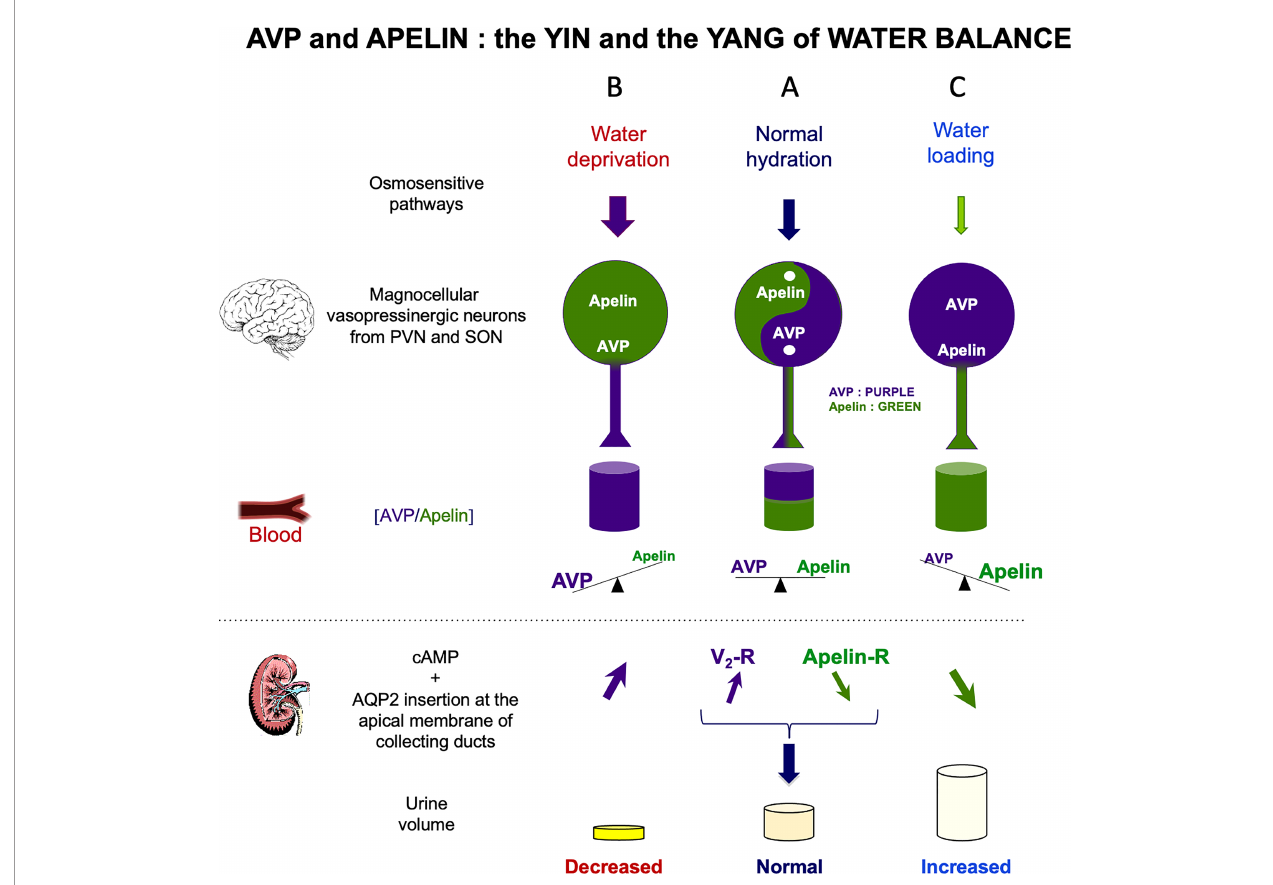
FIGURE 3 | Vasopressin (AVP) and apelin: the yin and yang of water balance (A) In physiological conditions, apelin (green) and AVP (purple) are released in balanced proportions from the magnocellular AVP neurons, at levels appropriate for plasma osmolality. In the collecting duct of the kidney, AVP acts on V2-R to increase cAMP production and aquaporin-2 (AQP2) insertion into the apical membrane, leading to water reabsorption. Apelin has the opposite effect, through its action on the ApelinR. Water reabsorption is adequate in physiological conditions. (B) Following water deprivation in rodents: 1) AVP is released from magnocellular vasopressinergic neurons into the bloodstream more rapidly than it is synthesized, causing a depletion of AVP magnocellular neuronal content; 2) apelin release into the bloodstream decreases and apelin accumulates in magnocellular neurons. Thus, after dehydration, AVP and apelin are regulated in opposite manners, to facilitate systemic AVP release and suppress diuresis. (C) Following water loading in rodents: 1) AVP release is decreased from magnocellular vasopressinergic neurons into the bloodstream, causing an accumulation in AVP magnocellular neuronal content; 2) apelin release into the bloodstream increases, leading to a depletion of apelin magnocellular neuronal content. Thus, after water loading, AVP and apelin are regulated in opposite manners, to facilitate systemic apelin release and to increase aqueous diuresis. Figure adapted from Ref. (74) with permission from the copyright